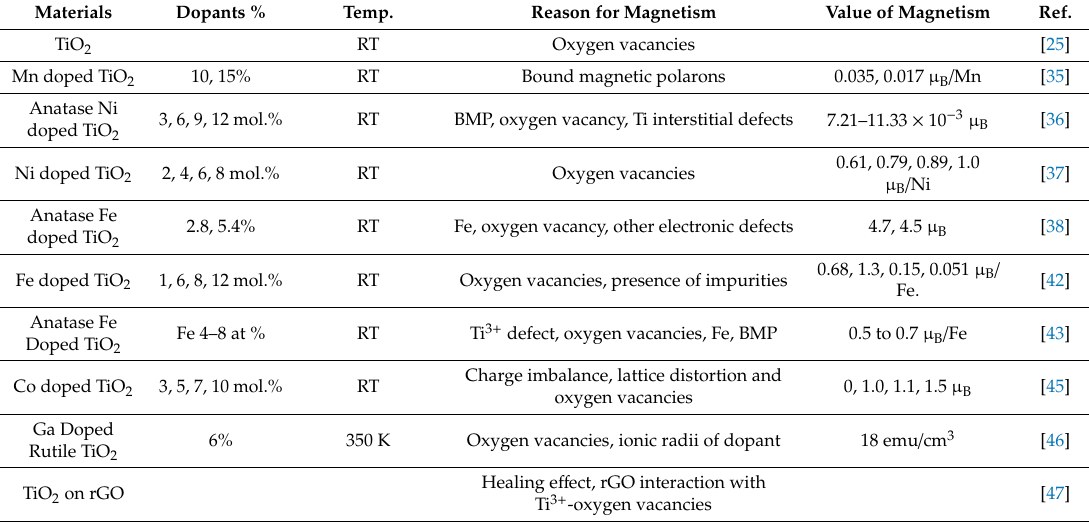
Table 1. Reports on magnetism data on TiO 2 with various